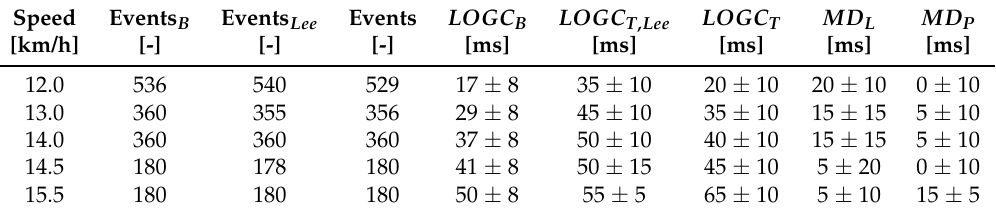
Table 4. Detected events of LOGC and LOGC timing values, calculated according to inertial analysis (Lee’s and Proposed approach) and high-speed camera (benchmark). The benchmark values are Events B and LOGC B ; the values calculated according to Lee’s method are Events Lee and LOGC T , Lee ; the values calculated according to our proposed method are Events and LOGC T . MD L and MD P refer, respectively, to the mean difference in LOGC estimation between the Lee’s approach and video analysis, and between our proposed approach and the video